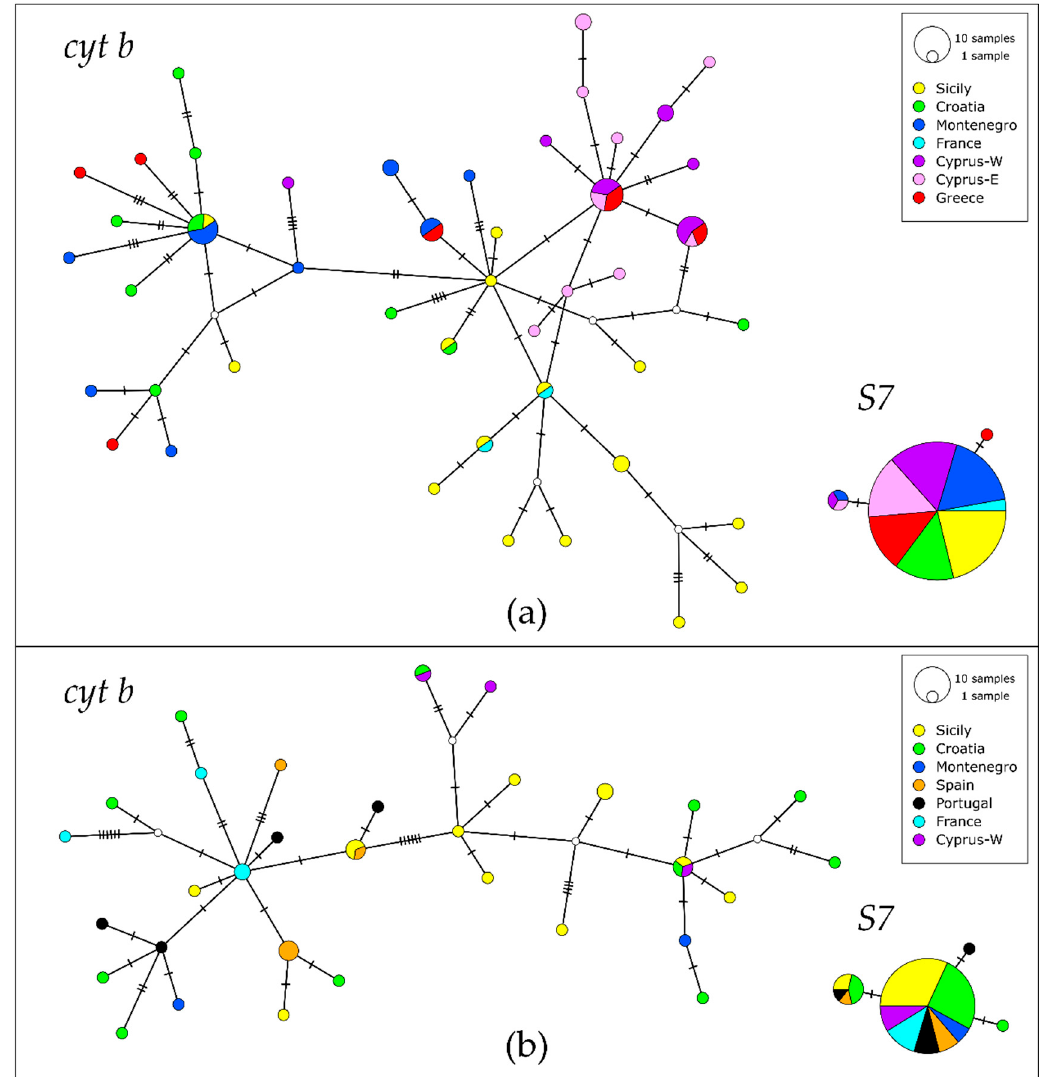
Figure 3. Haplotype networks of Gobius geniporus ( a ) and G. cruentatus ( b ) based on cytochrome b and S7 sequences. Size of circle is proportional to haplotype frequency. The number of mutational steps between closest haplotypes is indicated by hatch marks. Missing intermediate haplotypes are shown as small white circles.